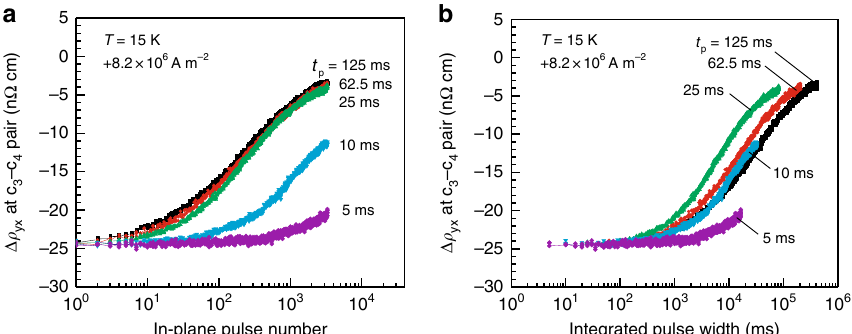
Fig. 5 Viscoelastic characteristics of the topological unwinding. a , b Δ ρ yx vs. in-plane pulse number ( a ) and vs. integrated pulse width ( b ) for various pulse width, t p , plotted on a logarithmic scale. The integrated pulse width represents the pulse number multiplied by each pulse width; the data shown in a , b are the same data presented in a different manner. Measurements were performed at 15 K and 0.249 T with a fi xed pulse magnitude, +8.2 × 10 6 A m − 2 (current fl owing from c 1 to c 2 : see Fig. 2c,